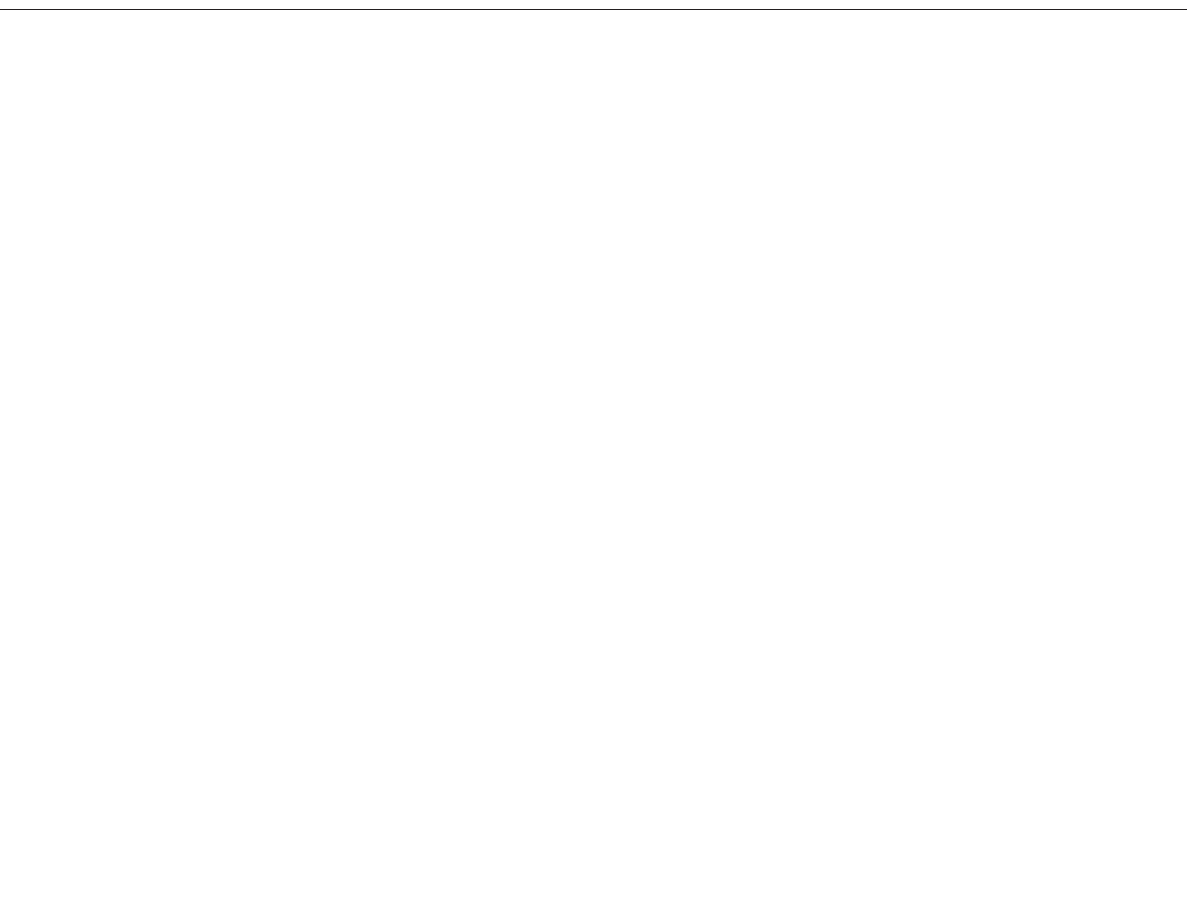
Frontiers in Microbiology |